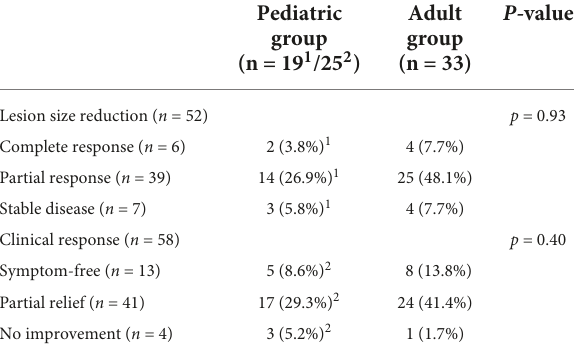
TABLE 4 Comparison of outcomes between pediatric and adult